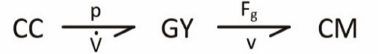
Fig. 1. Cylinder, piston and crankshaft assembly represented by a bond graph [9] The power of the working gas in combustion chamber (CC) volume is described by a product of cylinder gas pres- sure p and rate of CC volume . The piston appears to be V(cid:15)